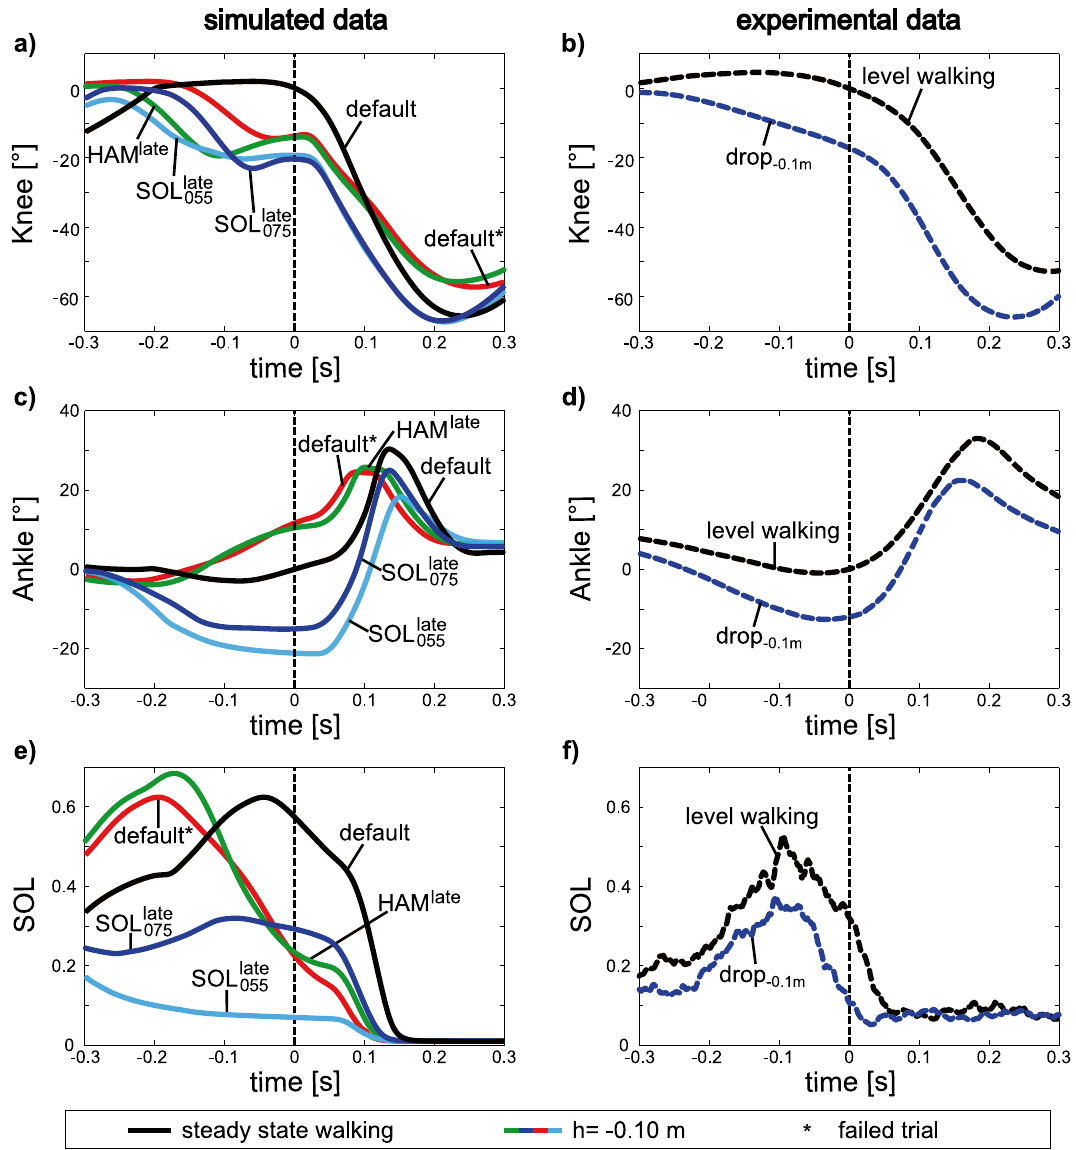
Figure 6. Shown are the kinematics (angle) of the knee ( a , b ) and ankle joint ( c , d ) and the muscle activity patterns ( e , f ) of the M. soleus (SOL) of the contralateral leg for level and perturbed walking (perturbation height h = − 0.10 m). All data are triggered to the heel strike of the ipsilateral contact (C 1 ) (t = 0, vertical dashed line). For the curves of the simulated data (horizontal steady state CoM velocity 1.36 m/s), on one side trials with the default gain values and on the other side trials of the late anticipatory SOL ( G 0SOL = 0.75/ F maxSOL ; G 0SOL = 0.55/ F maxSOL ) and HAM adjustments ( G 0HAM = 4) were selected. The curves of the experimental data (horizontal steady state CoM velocity 1.22 m/s) are generated by the mean of knee and ankle joint angles from eight subjects. Note: The ankle joint angles of simulated and experimental data differ. The leg joint angles are given relative to the joint angles at the ipsilateral heel strikes of the level walking trials (solid and dashed black